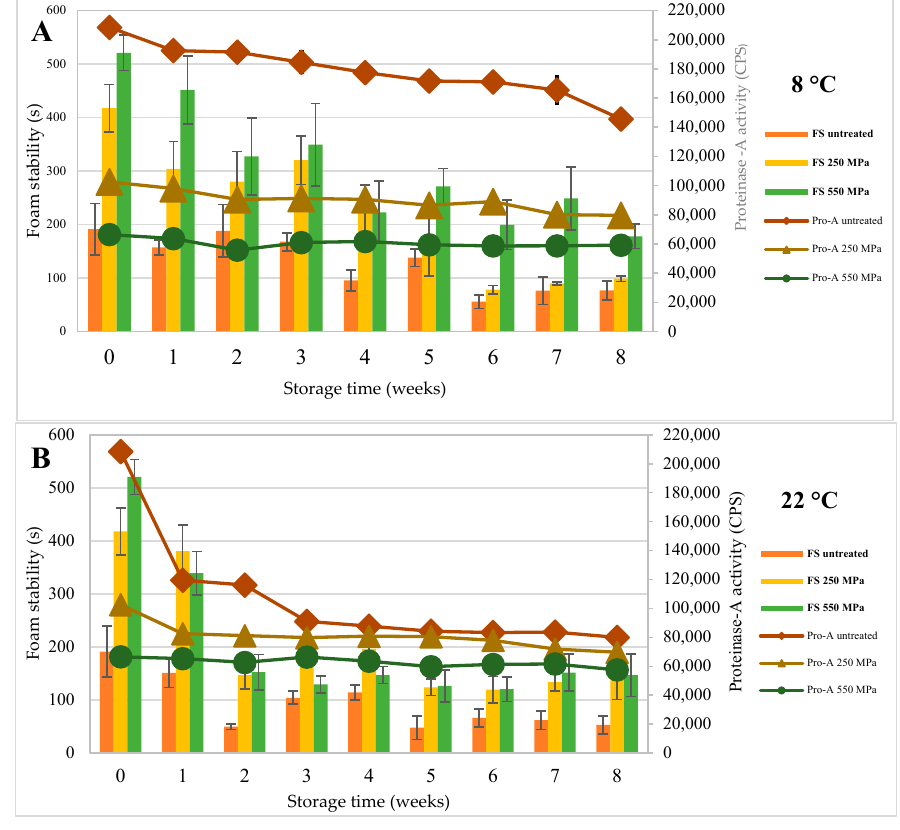
Figure 1. Impact of high-pressure treatment at 250 MPa for 5 min or 550 MPa for 5 min on the foam stability (FS, in columns) and the activity of proteinase A (pro-A, inline connections) compared with the untreated sample during 8 weeks of storage at ( A ) 8 ◦ C or ( B ) 22 ◦